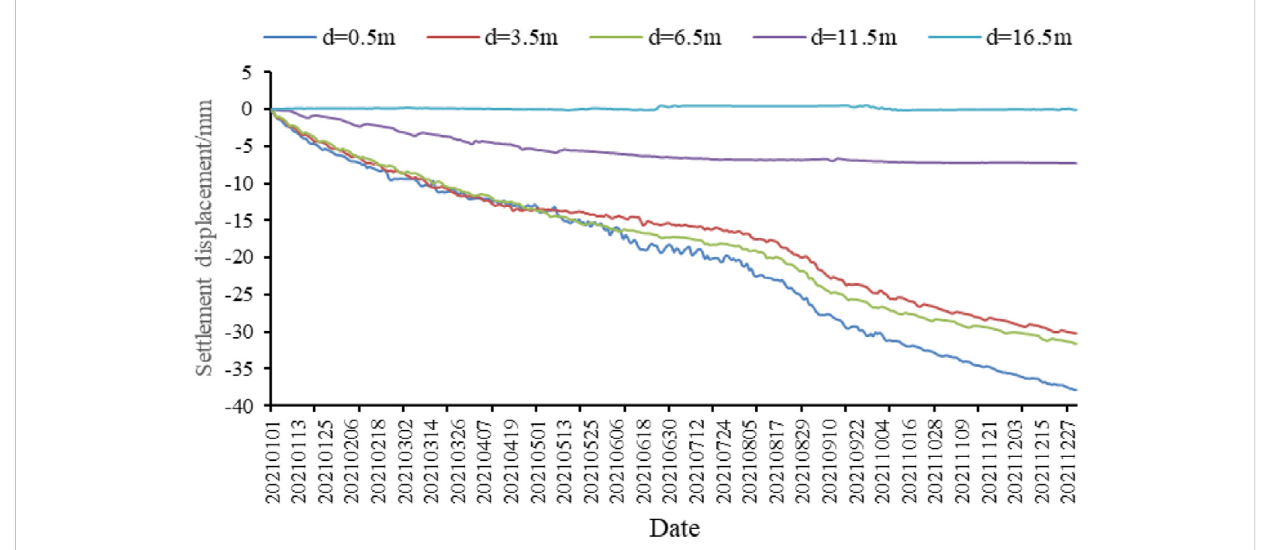
FIGURE 15 Settlement displacement monitoring curve of F4